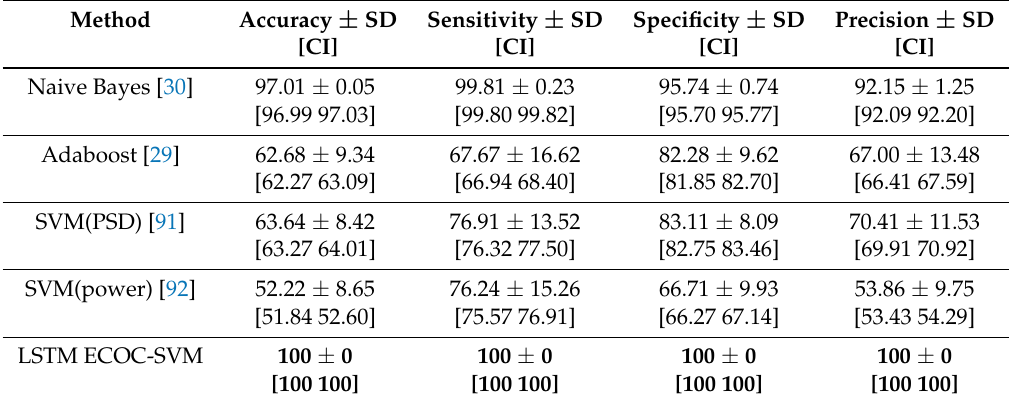
Table 10. Accuracy, Sensitivity, Specificity and Precision for the Performance existing works and proposed convolutional neural network (CNN) ECOC-SVM Voting Ensembles Architecture. (The Numbers in Bold Indicate the Best Value Obtained for Each Quality